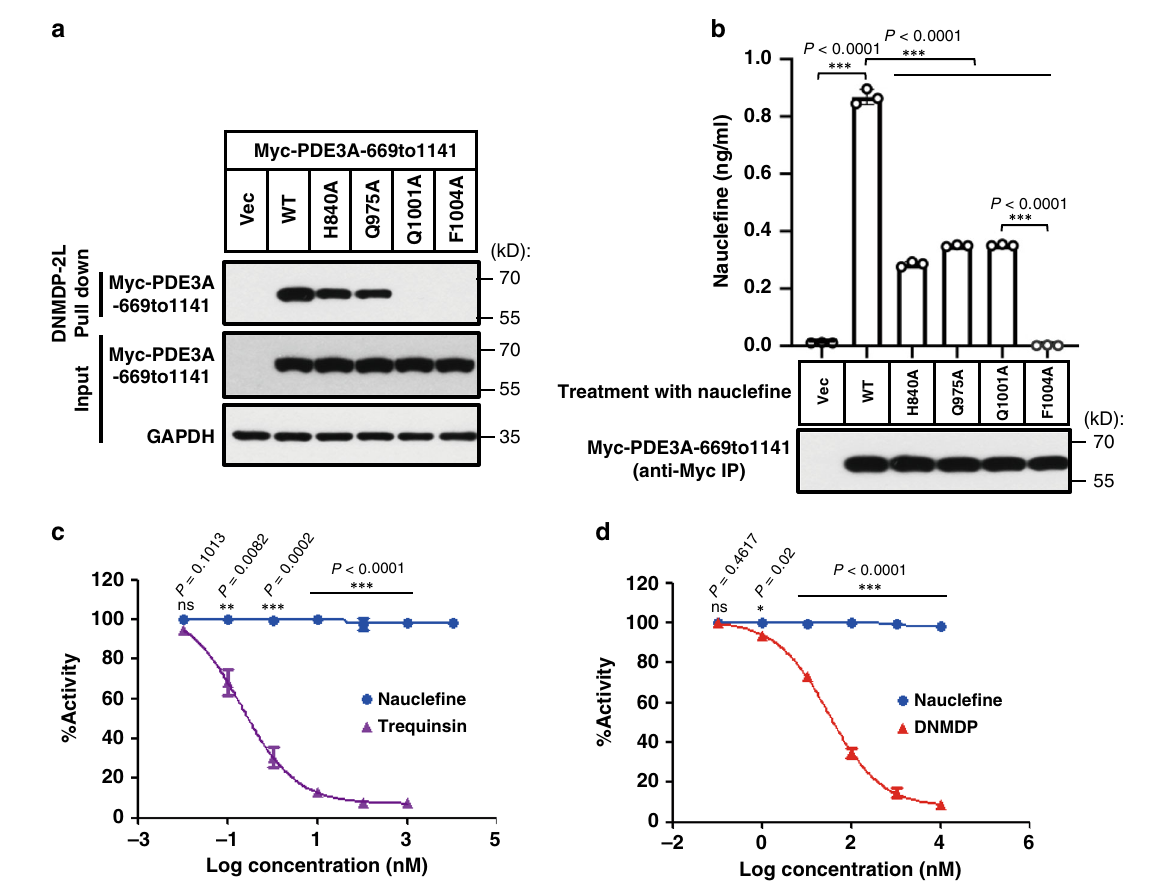
Fig. 3 Naucle fi ne binds PDE3A without affecting its phosphodiesterase activity. a Pull-down assay of DNMDP-2L binding to Myc-tagged PDE3A (aa 669 – 1141) WT and to the indicated mutant variants. This is a representative result from three independent experiments. b Myc-tagged PDE3A (aa 669 to 1141) WT and the indicated mutant variants were immunoprecipitated with Myc-beads. The bound PDE3A proteins were detected by western blotting. The bound naucle fi ne was quanti fi ed via LC – MS/MS. The presented result (mean ± SD) is representative of two experiments with three replications in each experiment. Student ’ s t test (two-tailed, unpaired) was performed. The indicated concentrations of trequinsin and naucle fi ne ( c ), or DNMDP and naucle fi ne ( d ) were added to the insect-cell puri fi ed PDE3A protein in the presence of cAMP for 90 mins. At the end of the assay, the remaining cAMP was measured by LC – MS/MS. This is a representative result (mean ± SD) from two independent experiments with three replicates each time. Student ’ s t test (two-tailed, unpaired) was performed: * p < 0.05; ** p < 0.01; *** p < 0.001; ns not signi fi